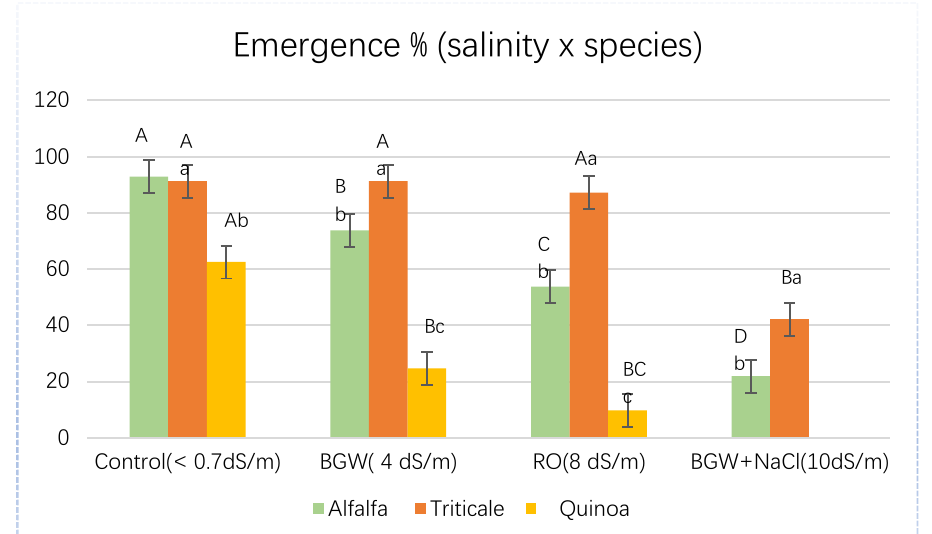
Figure 3. Emergence % of alfalfa, triticale, and quinoa with salinity × species interaction at four different salinity levels. A, B, C letters correspond to significant differences in the emergence % within the species at different salinity levels and a, b, c letters correspond to statistically significant differences in the emergence % between the species at α ≤ 0.05. Standard errors for emergence % of species x salinity are constant for alfalfa (±5.87), triticale (±5.59), and quinoa (±5.80) respectively.